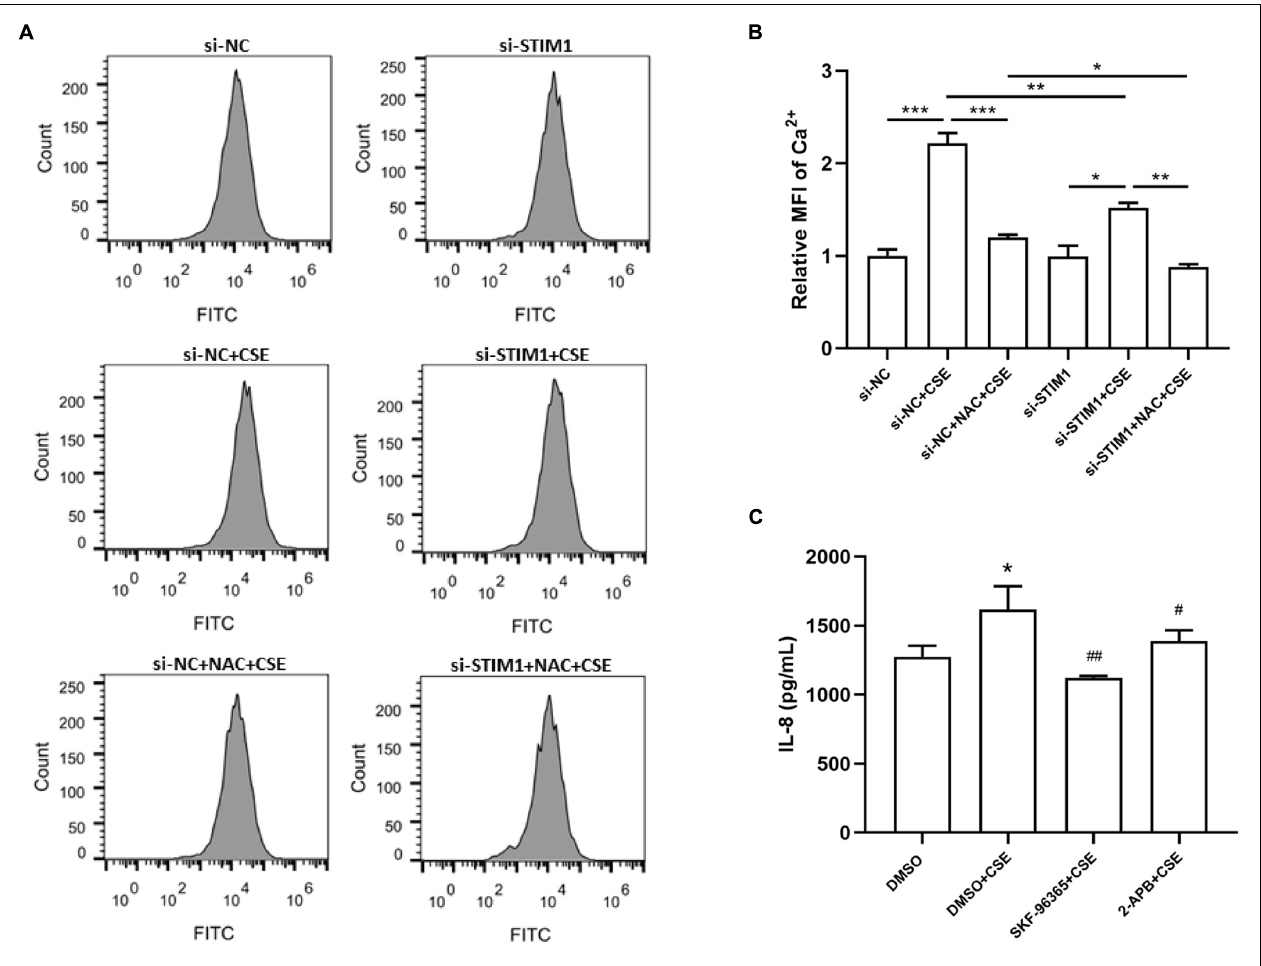
FIGURE 5 | Reactive oxygen species-stromal interaction molecule 1-regulated IL-8 increase is mediated by intracellular Ca2 + level in CSE-stimulated PMA-differentiated THP-1 cells. The representative images of flow cytometry for detection of intracellular Ca2 + are shown (A) and quantified by FlowJo (B) . Knockdown of STIM1 and pretreatment of 3 mM NAC in PMA-differentiated THP-1 cells alleviated CSE-induced intracellular Ca2 + increase. 2-h Pretreatments by SKF-96365 and 2-APB, respectively, the Ca2 + channel inhibitors, mitigated IL-8 increase 48 h after 5%CSE stimulation (C) . Data are expressed as mean ± SEM of at least three independent experiments. P -values were calculated using one-way ANOVA followed by Newman–Keuls test. * P < 0.05, ** P < 0.01, and *** P < 0.001 vs. si-NC or DMSO. # P < 0.05, ## P < 0.01 vs. DMSO + CSE. NC, negative control; STIM1, stromal interaction molecule 1; MFI, Mean fluorescent intensity; CSE, cigarette smoke extract; NAC, N-acetylcysteine; DMSO, dimethyl sulfoxide; and PMA, phorbol myristate